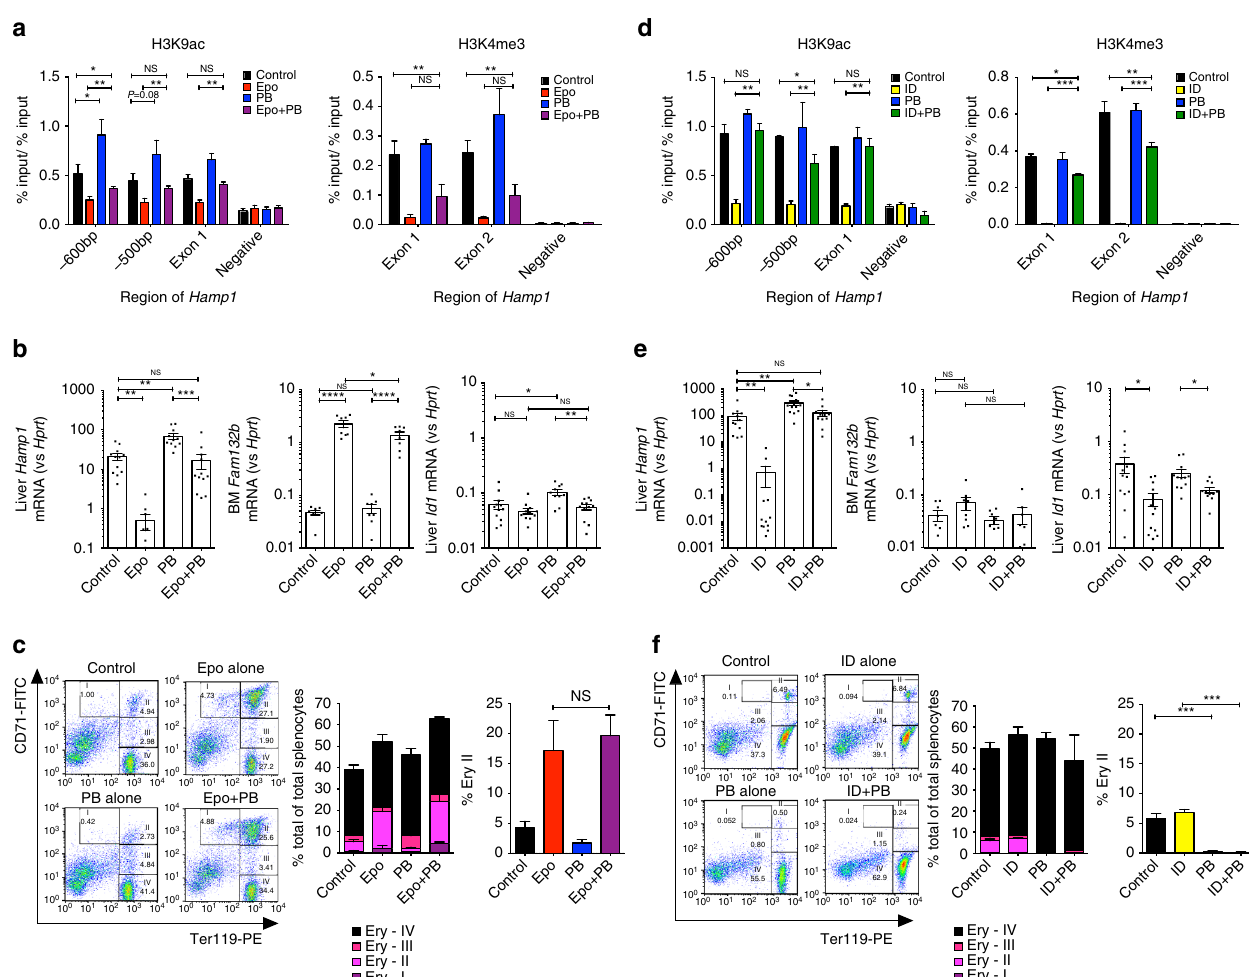
Fig. 4 Effects of Epo treatment or ID with PB co-administration. six- to eight-week-old C57Bl/6 male mice were treated with 200 IU Epo per day for 3 days with or without Panobinostat 0.4 mg (20 mg/kg) ( a – c ). a ChIP-qPCR data for hepatic H3K9ac and H3K4me3 at the Hamp1 locus, and b hepatic Hamp1 mRNA expression, bone marrow Fam132b mRNA expression, and hepatic Id1 mRNA expression. For a , N = 3 – 4 per group. For b N = 12 per group. (Three identical experiments comprising four mice per group were performed, and are presented here as combined data.) c Effects of Epo and PB on erythropoiesis. Examples of fl ow scatterplots of CD71 vs Ter119 from cells isolated from spleens from mice treated with each condition (Control, Epo, PB, Epo + PB) are shown, together with a summary of the effects of each condition on erythroblast maturation, with speci fi c comparison of intermediate erythroblasts between groups ( n = 4 per group). d – f Six-week-old C57Bl/6 male mice were given an iron-de fi cient diet for 2 weeks with or without Panobinostat 0.4 mg (20 mg/kg) for the last 7 days. Effects on c H3K9ac ( N = 3 per group) and H3K4me3 ( N = 2 per group), d hepatic Hamp1 mRNA expression, bone marrow Fam132b mRNA expression, and hepatic Id1 mRNA expression. (For d , N = 3 – 4 per group. For e N = 12 per group — three identical experiments comprising four mice per group were performed, and presented as combined data.) f Effects of ID and PB on erythropoiesis. Student ’ s t -test. Animals in this experiment are partially included in the Epo vs control data presented in Fig. 1. Epo erythropoietin, ID iron-de fi cient diet, PB panobinostat. Data are means ± s.e.m. * P ≤ 0.05; ** P ≤ 0.01; *** P ≤ 0.001; **** P ≤ 0.0001; NS, P >